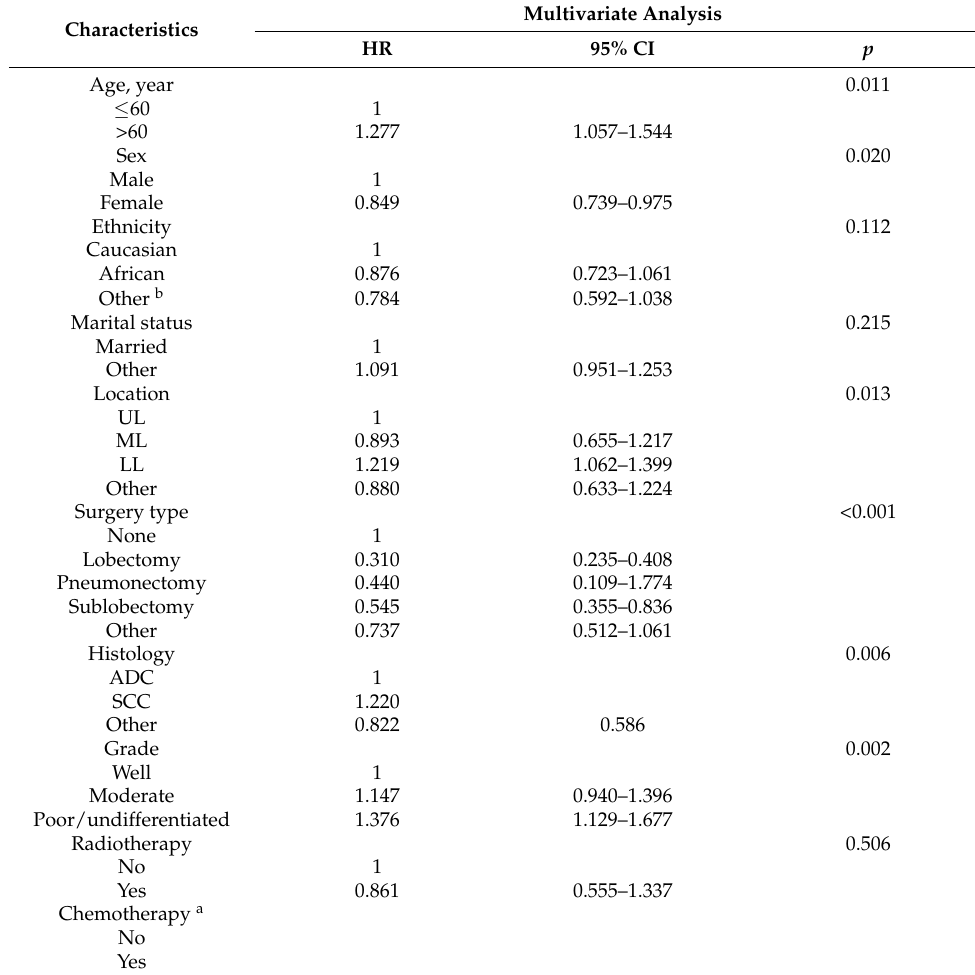
Table 3. Prognostic score of each covariate calculated based on the nomogram.